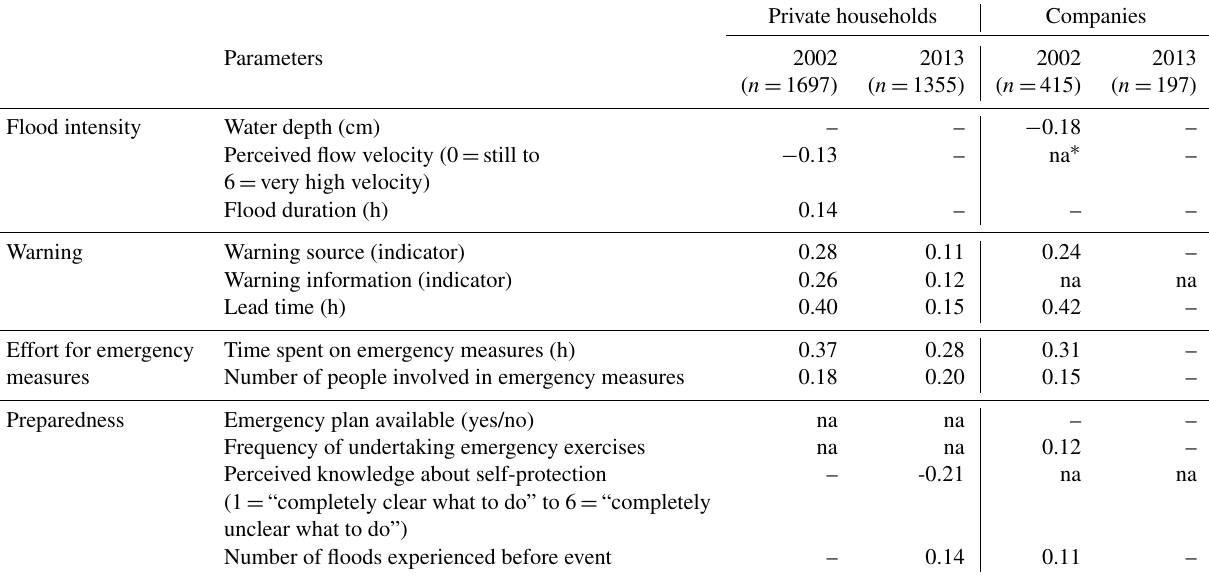
Table 5. Rank correlation (Spearman’s rho) between the indicator of effectively performed emergency measures and other parameters (only coefficients significant at the 0.05 level and >0.1 are